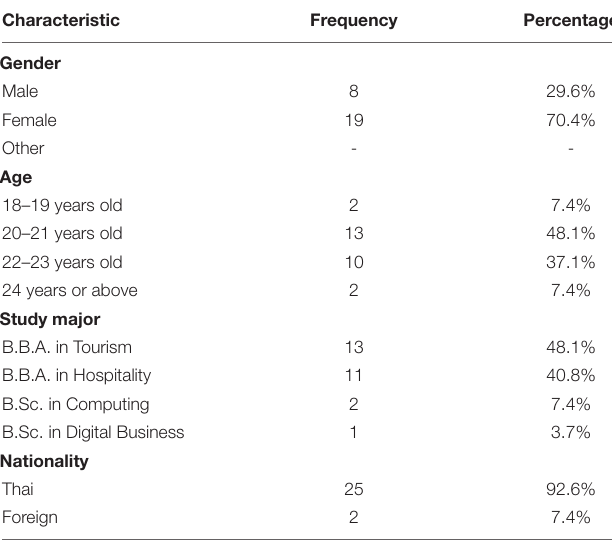
TABLE 2 | Socio-demographic profile of the interview participants (summarized from the transcripts).